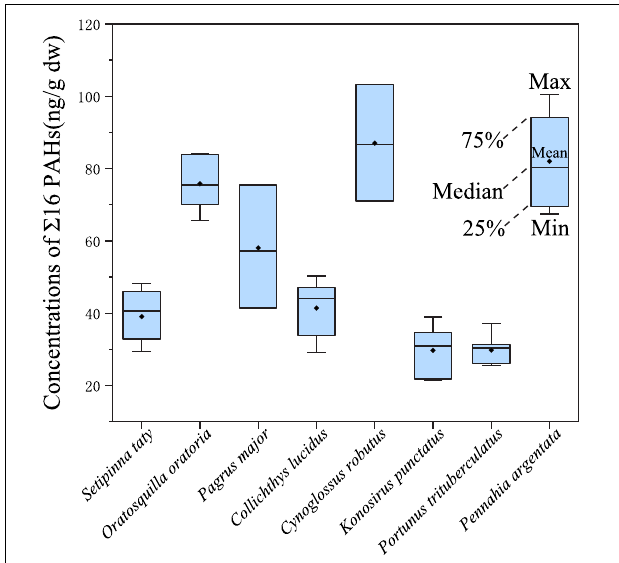
FIGURE 2 | Concentrations of (cid:54) 16PAHs in the marine organisms.